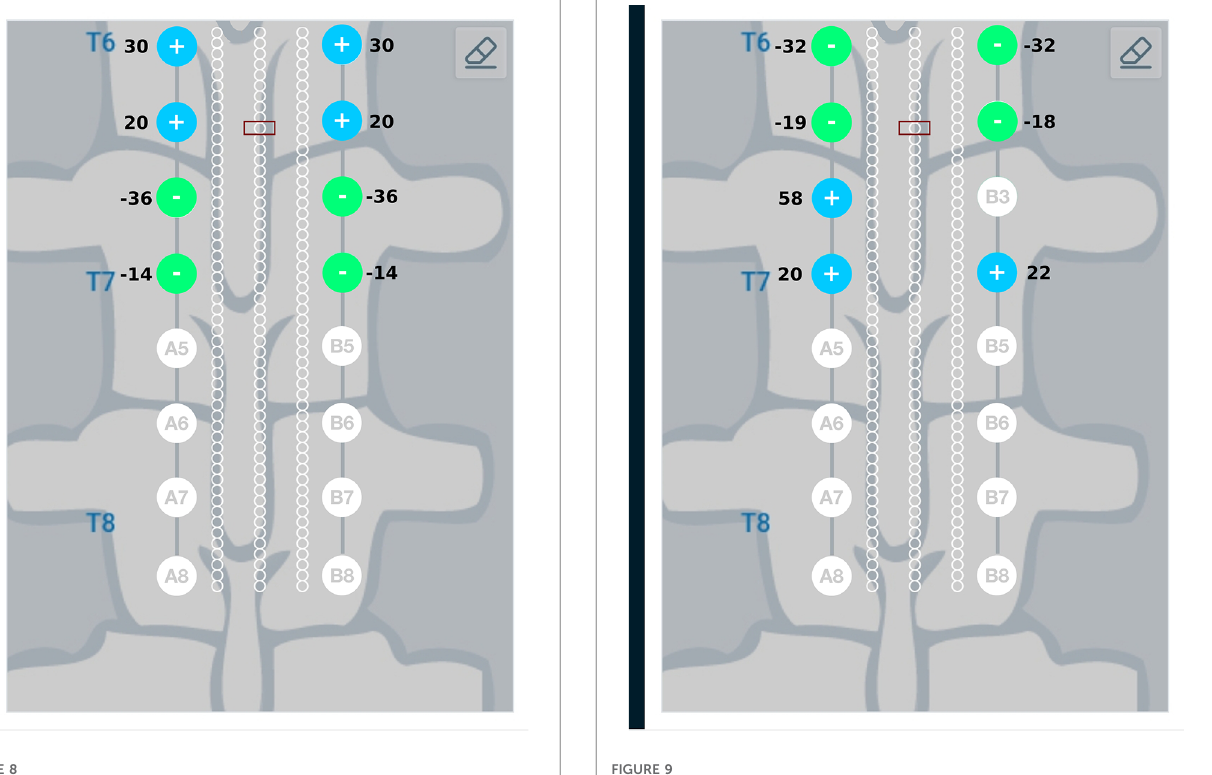
FIGURE 8 Current steering results graphically represented on the user interface. The current steering results are obtained in the form of the optimum electrode excitation pattern – shown on the parallel leads in this fi gure. Green, fi lled circles indicate current sinks and blue, fi lled circles indicate current sources. The numbers near the electrodes represent the relative percentage of current sourced/sunk through the electrodes.